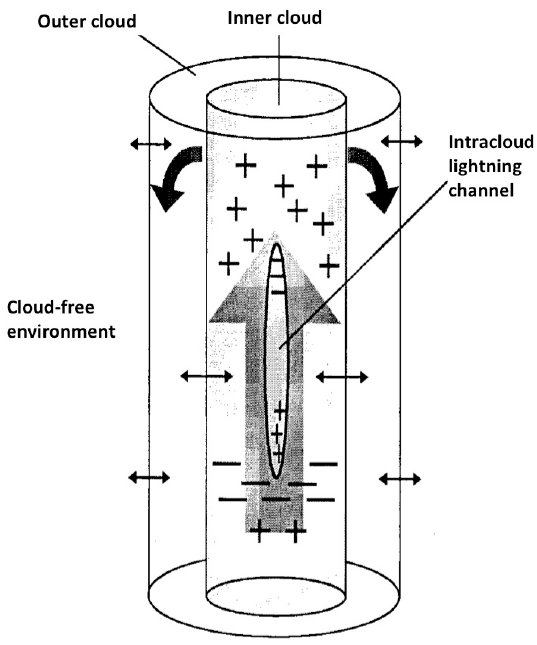
Fig. 1. Schematic diagram of the model geometry with two con- necting cloudy